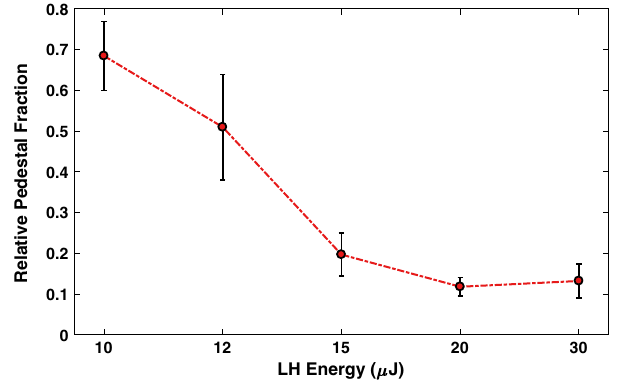
FIG. 10. Pedestal region strength normalized to total seed plus pedestal emission at U15 as a function of LH energy for the Oct. 2018 shift. The error bars refer to RMS